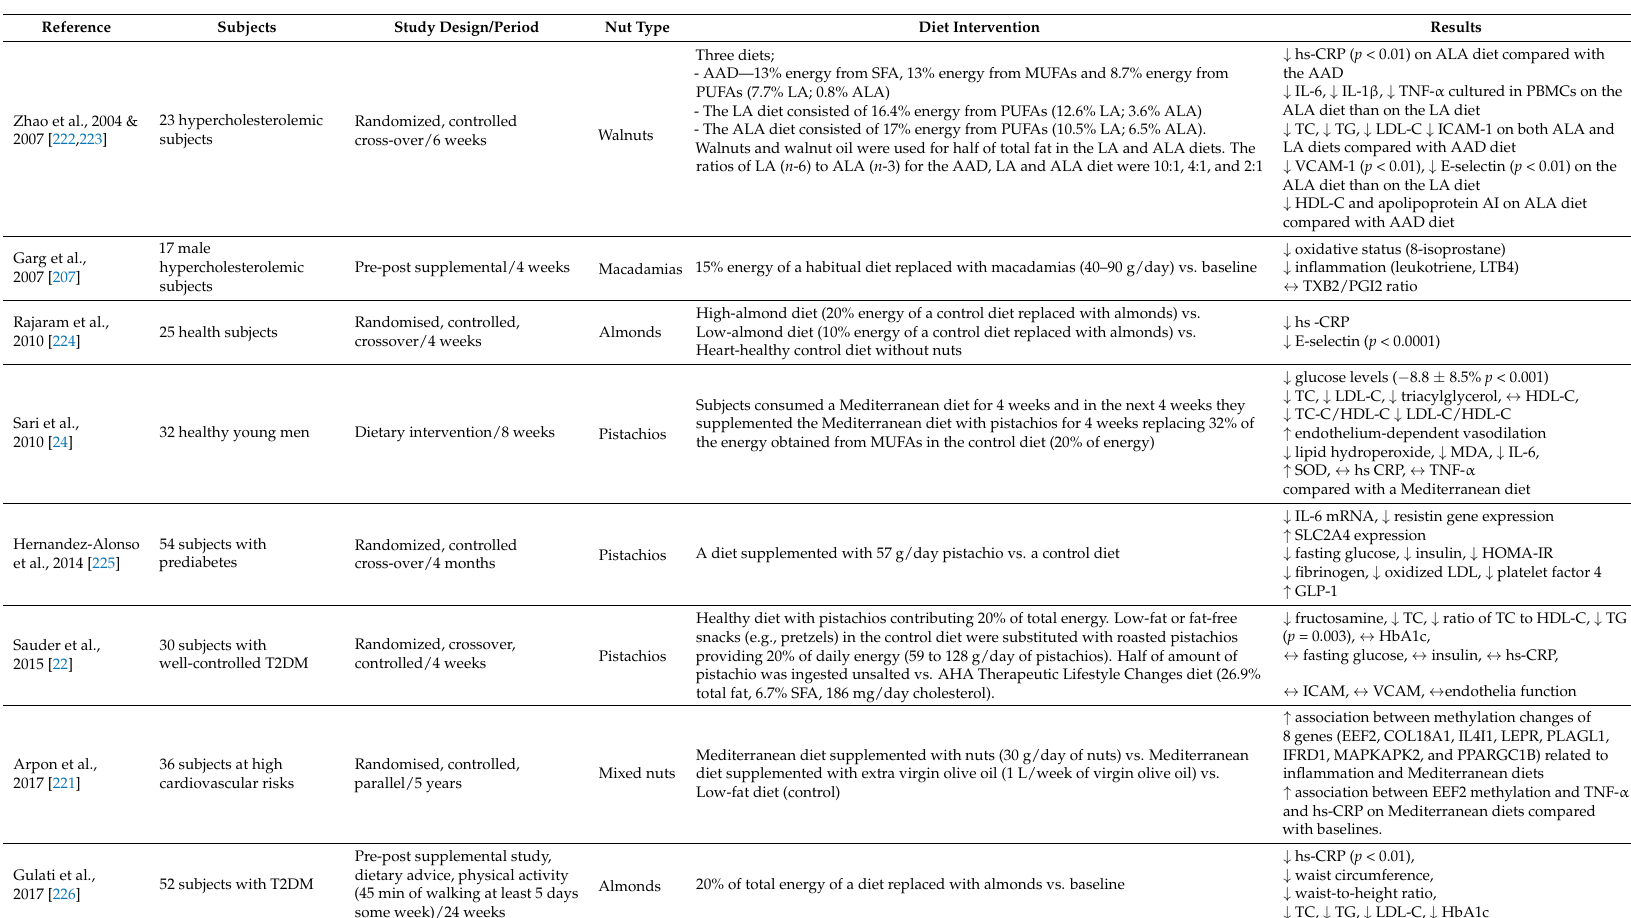
Table 5. Summary of clinical trials examining the effect of nut consumption on